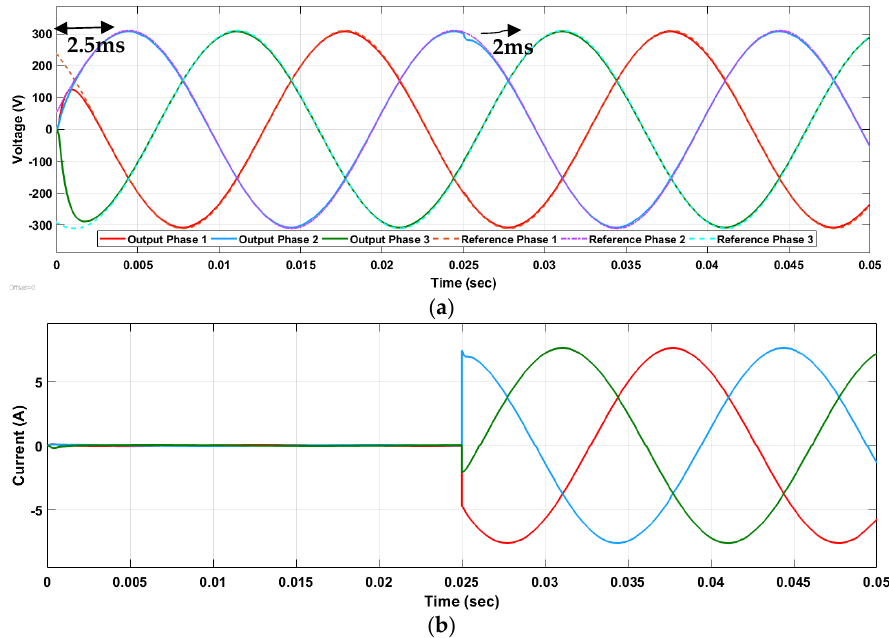
Figure 8. ( a ) EERL [24], output voltage-reference tracking trajectory and voltage regulation. ( b ) EERL [24], load current-step response under extreme load variation.